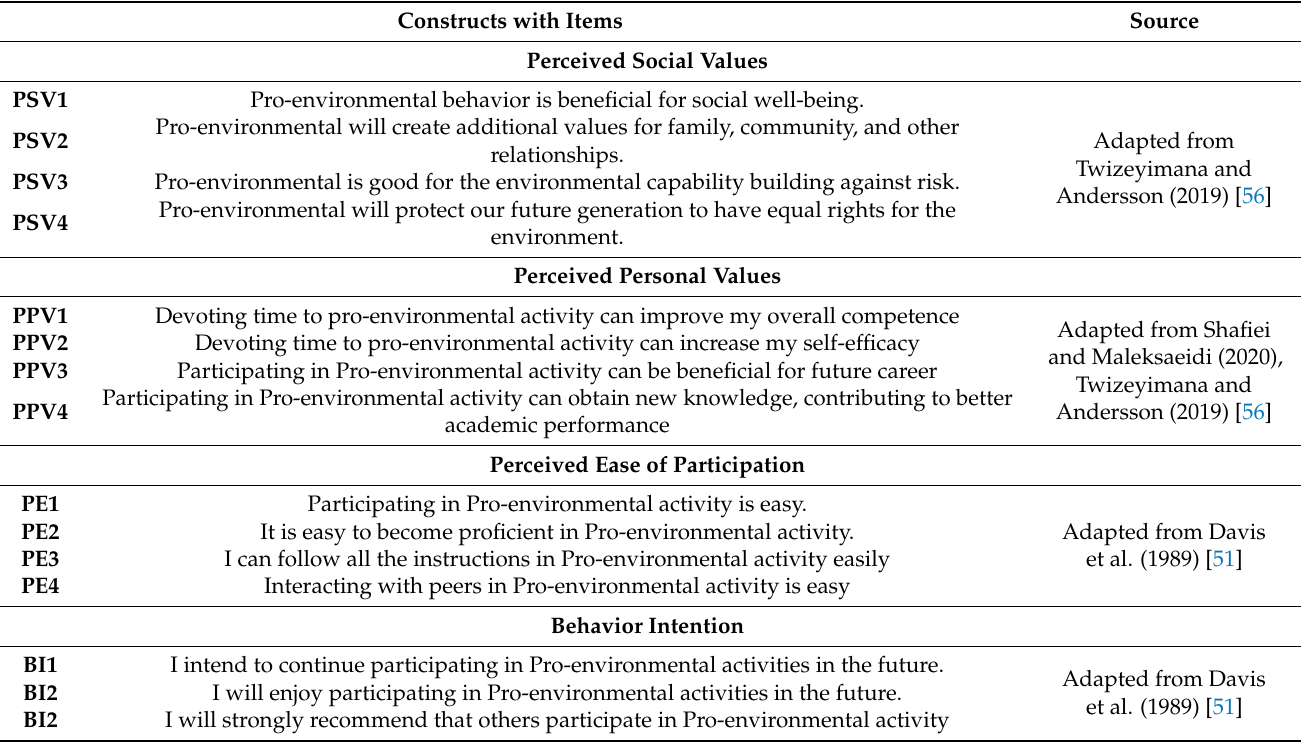
Table 1. Constructs and